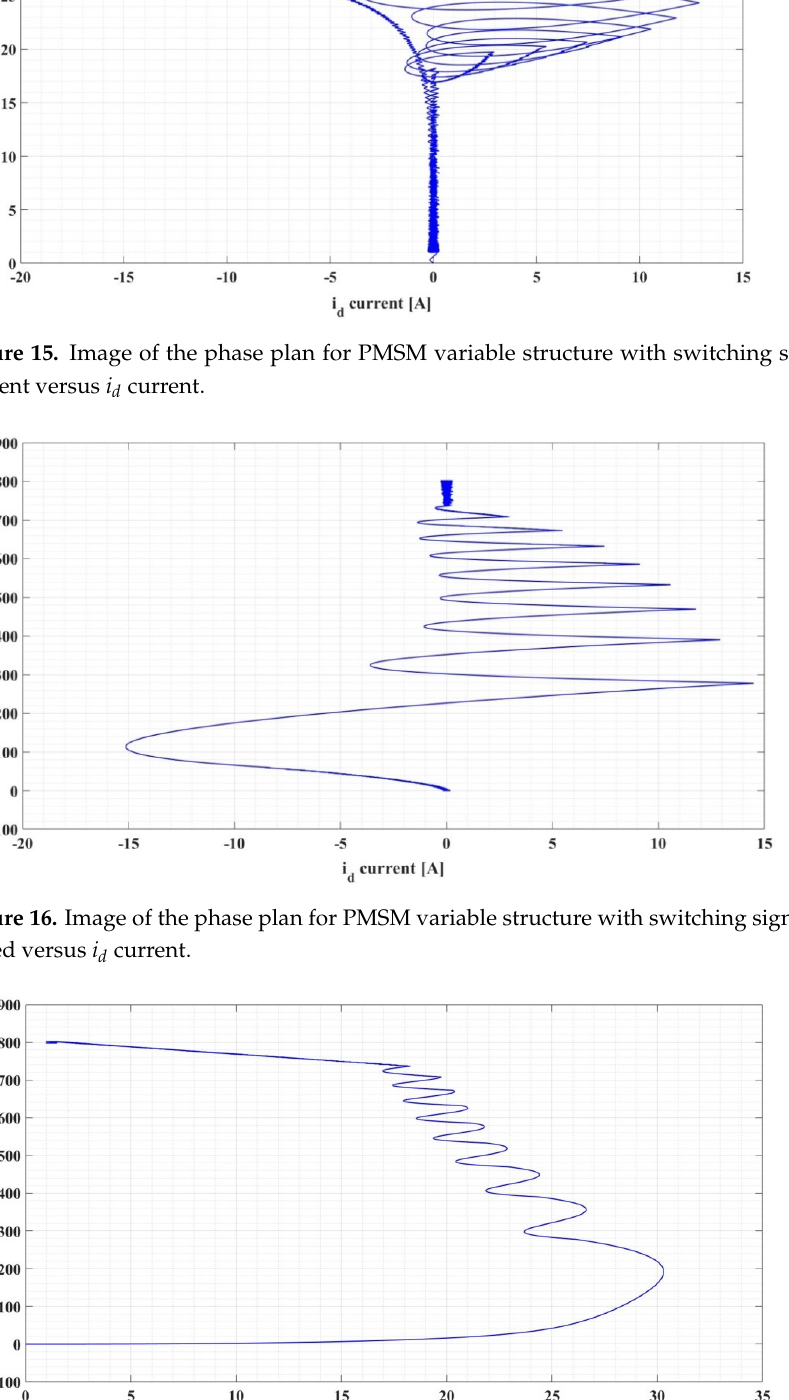
Figure 18. Image of the state space for PMSM variable structure with switching signal type 1: rotor speed versus i q current versus i d current ( ω ref = 800 rpm).